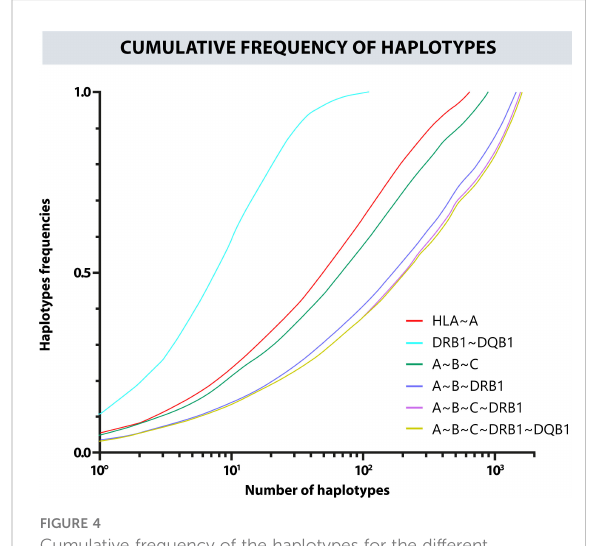
FIGURE 4 Cumulative frequency of the haplotypes for the different combinations of classic HLA loci.